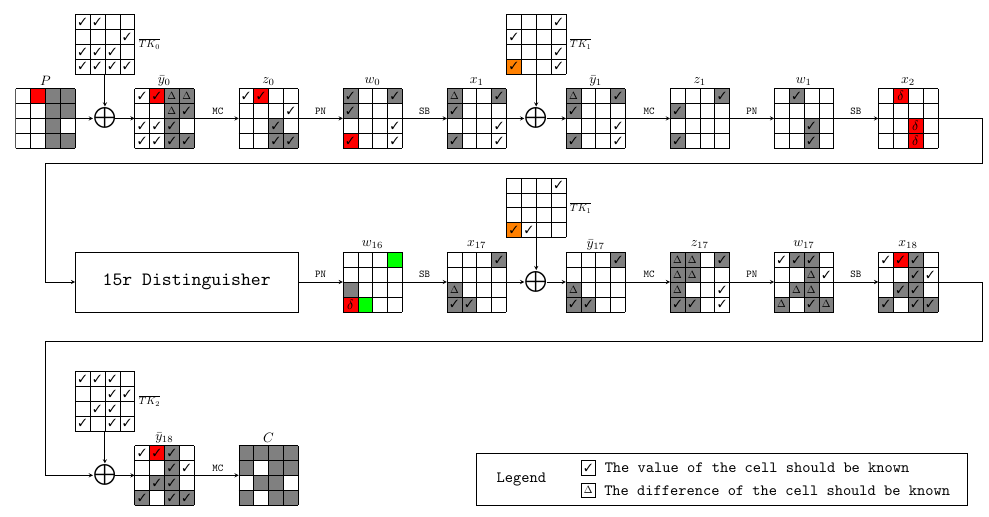
Figure 8: A key-recovery attack on 19-round